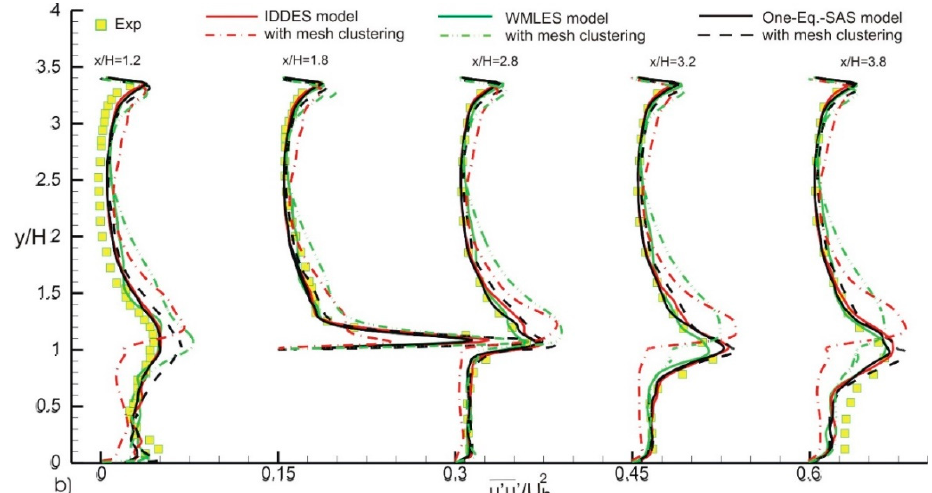
Figure 6. Effect of ( a ) mesh density, and ( b ) mesh clustering on the streamwise normalized Reynolds stress in the XY plane cutting through the center of the cube at z/H = 0. Aerospace 2019 , 6 , x FOR PEER REVIEW